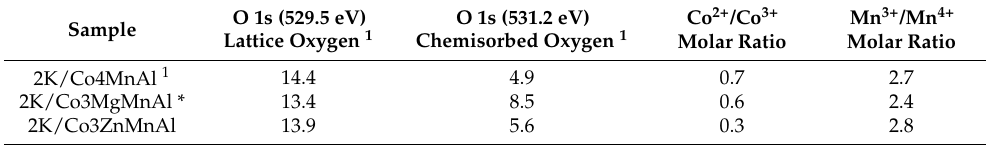
Table 3. Results of the deconvolution of the Co 2p, Mn 2p, and O 1s peaks from XPS (with